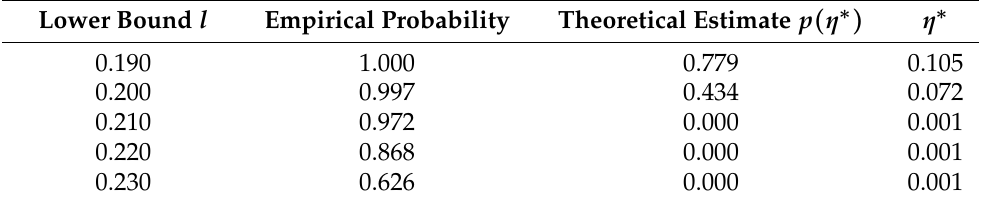
Table 2. Simulation results for B(0.25, 2), number genes = 20,000, proportion significant = 0.1, real power limit = 0.233737.